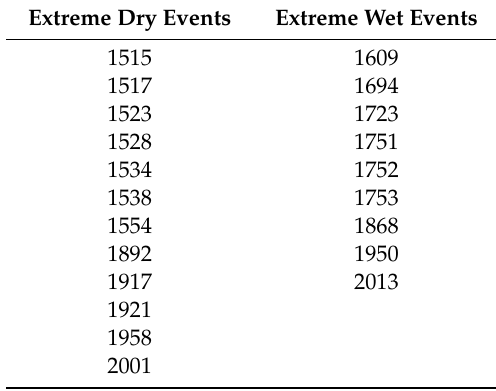
Table A2. Reconstructed extreme-dry and -wet events for the southern slope of the Alborz Mountains during the period